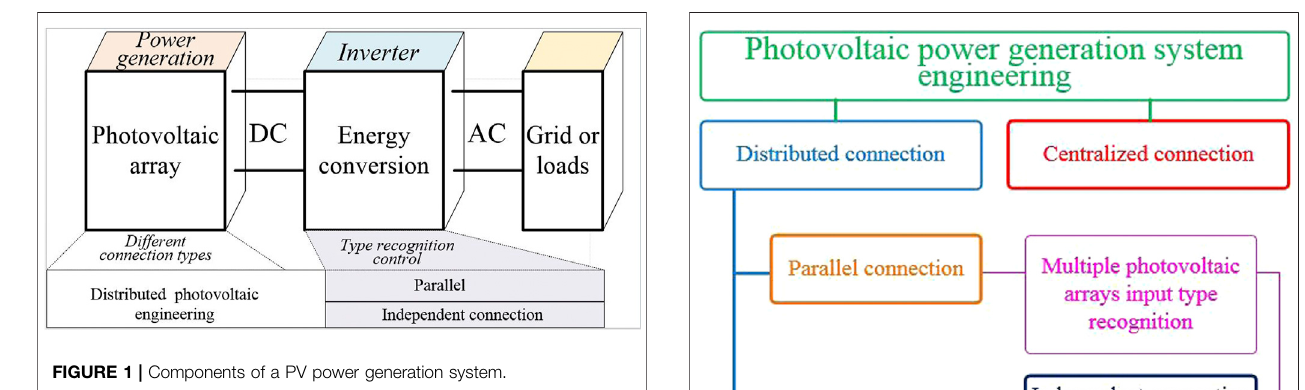
FIGURE 1 | Components of a PV power generation system.